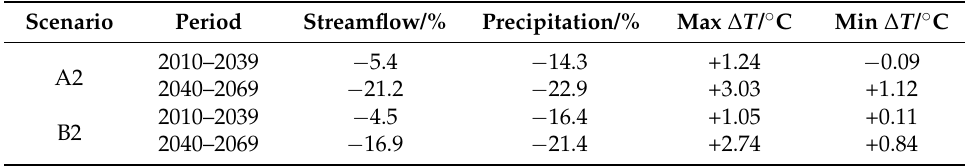
Table 5. Variations of averaged streamflow, precipitation, and temperature ( ∆ T) under scenarios A2 and B2 from 2010 to